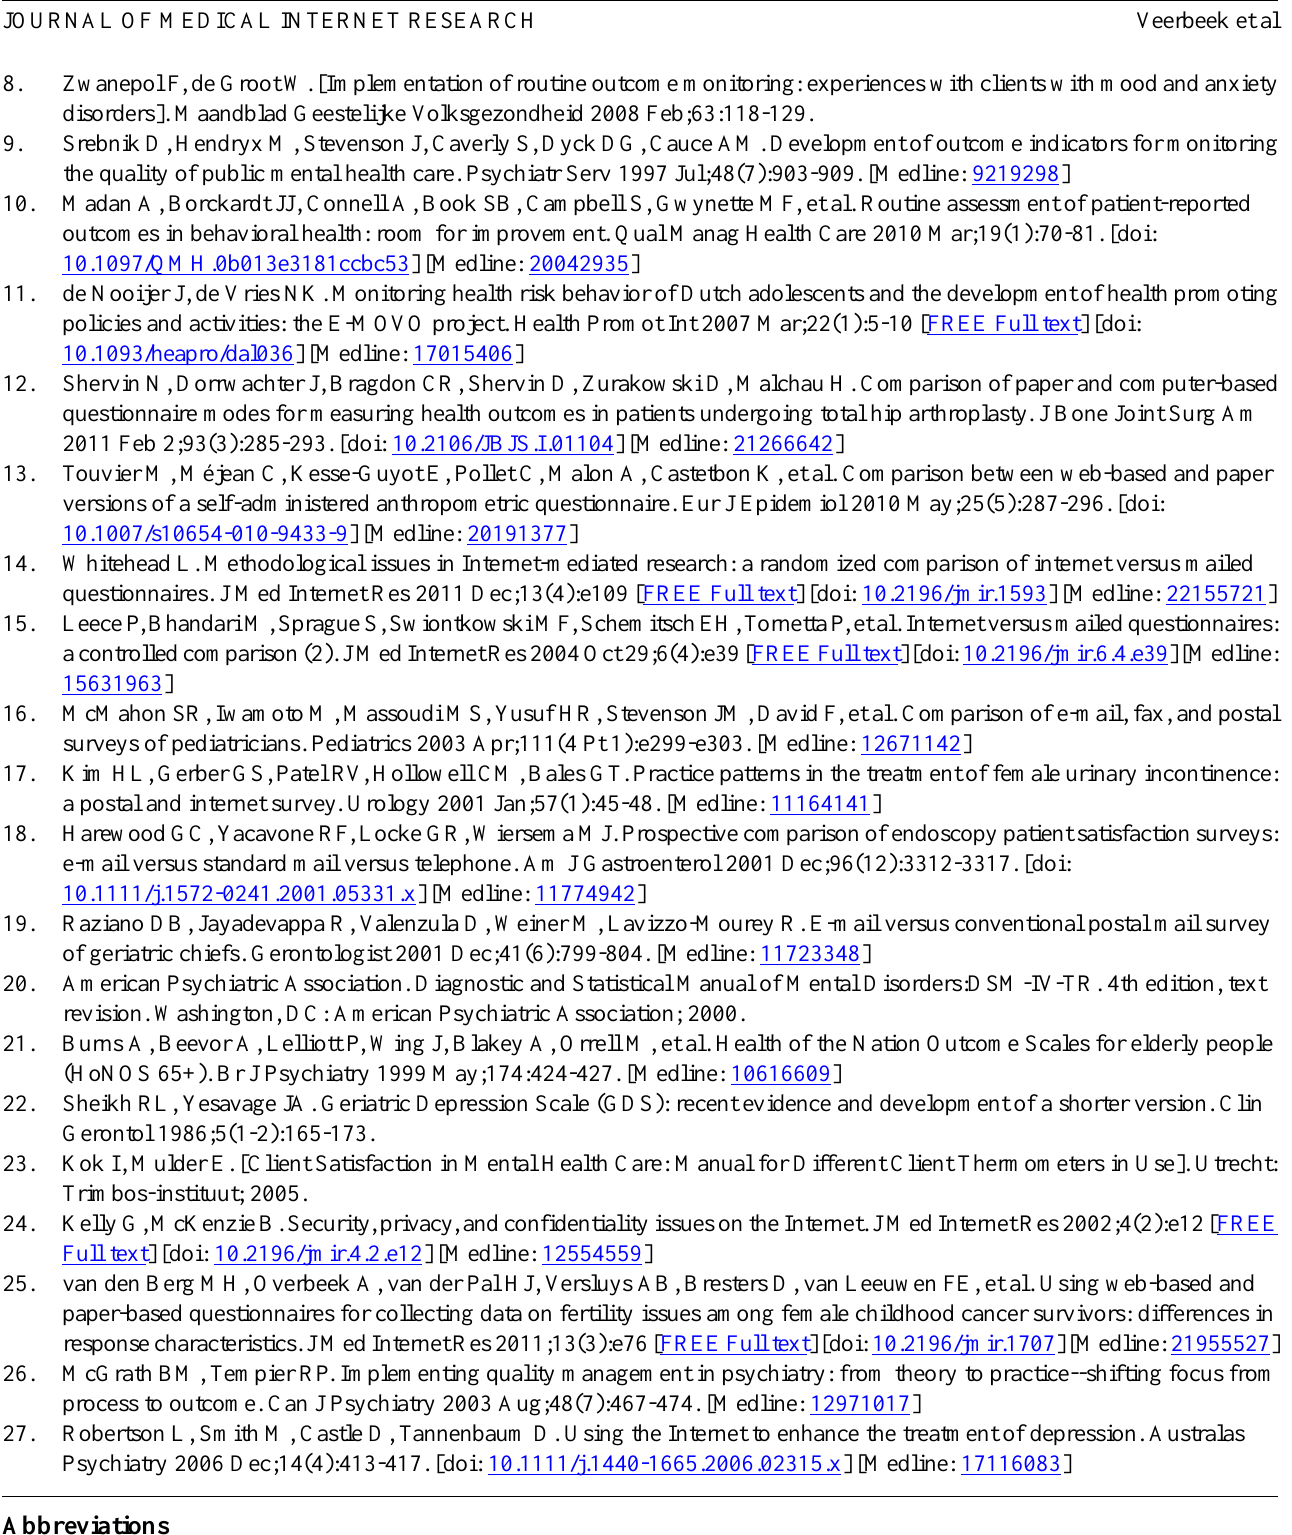
Abbreviations HoNOS 65+: Health of the Nation Outcome Scales for older adults MEMO: Mental Health Care Monitor Older